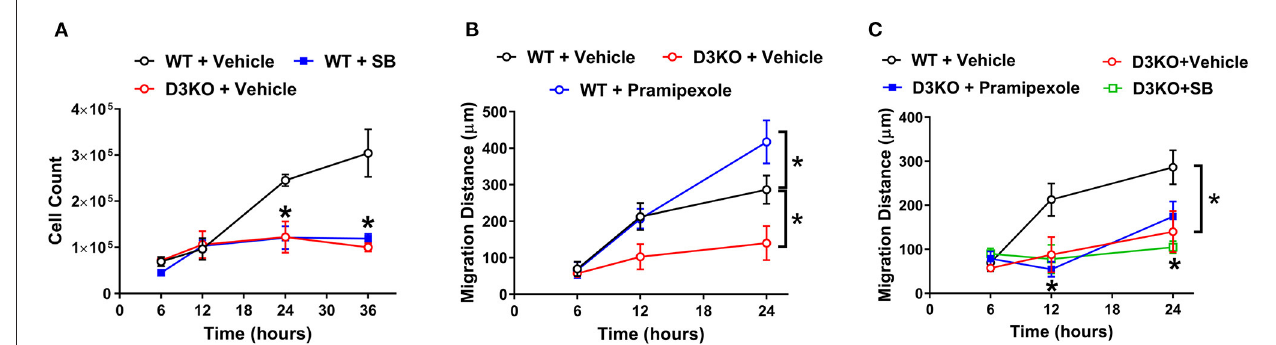
FIGURE 3 | Cardiac fibroblast cell proliferation and migration studies: (A) Cardiac fibroblast cell proliferation between WT + vehicle (black circle), WT treated with SB (closed blue square), and D3KO + vehicle (red circle) over a time-period of 36h. Cells were incubated in DMEM/F-12 growth media supplemented with 10% FBS; n = 3 for each treatment at each time-point, * p < 0.05 statistically significant. Bars represent standard error of mean. (B) Cardiac fibroblast cell migration distance in response to a scratch injury over a 24-h time-period. Migration distance in µ m between WT + vehicle (black circle), D3KO + vehicle (red circle), and WT cells treated with D3R specific agonist, pramipexole (blue circle). Cells were incubated in DMEM/F-12 growth media supplemented with 0.5% FBS; n = 9 for each treatment at each time-point, * p < 0.05 statistically significant. Bars represent standard error of mean. Statistical significance between WT treatment and D3KO + vehicle. (C) Cardiac fibroblast cell migration distance in response to a scratch injury over a 24-h time-period. Migration distance in µ m of D3KO + vehicle cells (red circle), D3KO cells treated with pramipexole (closed blue square), and D3KO cell treated with SB (green square), compared against WT + vehicle cells (black circle); n = 9 for each treatment at each time-point, * p < 0.05 statistically significant. Bars represent standard error of